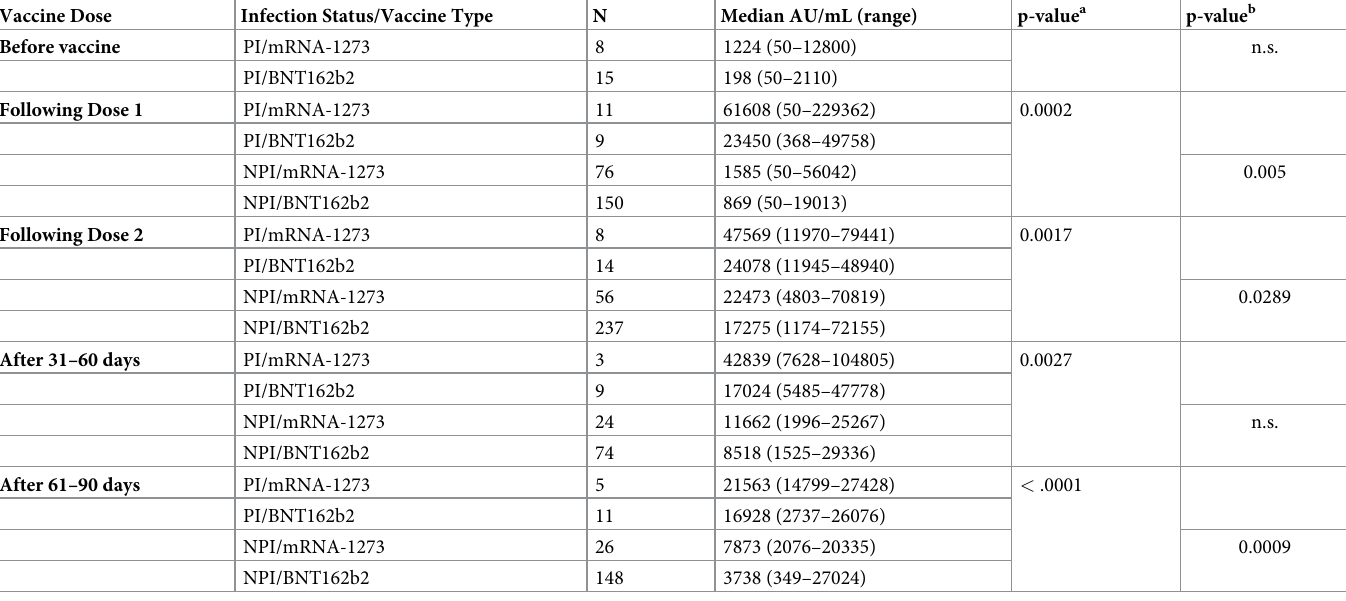
Table 2. Summary statistics of anti-spike IgG responses by vaccine type and infection history. Vaccine